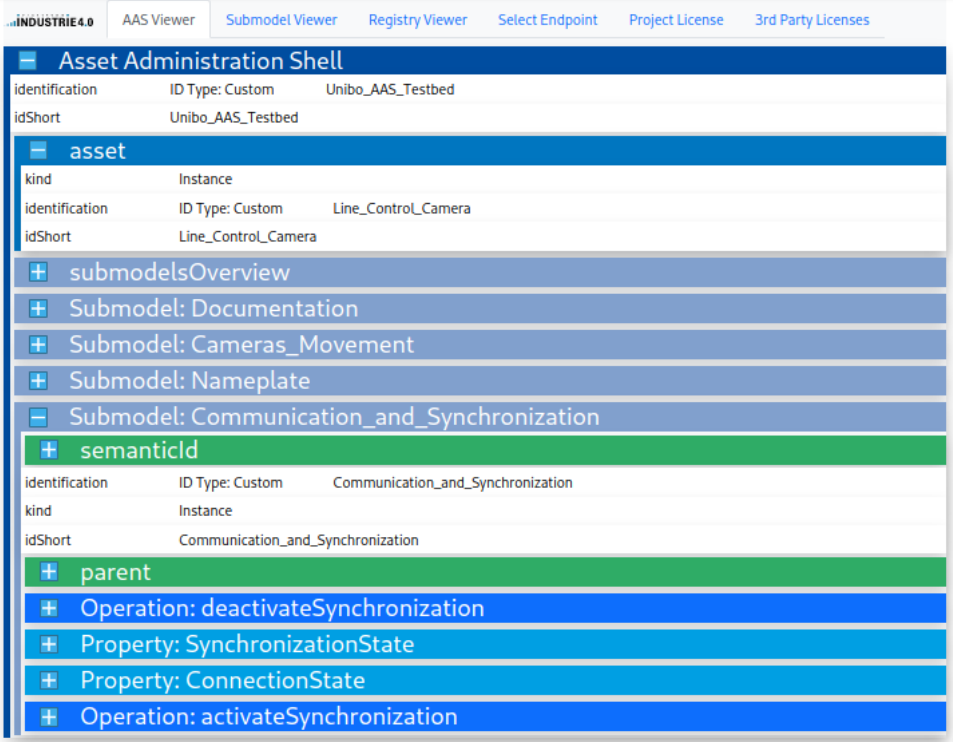
Figure 4. Screenshot of the Asset Administration Shell demonstration with the list of submodules, where the API of the Communication and Synchronization model is